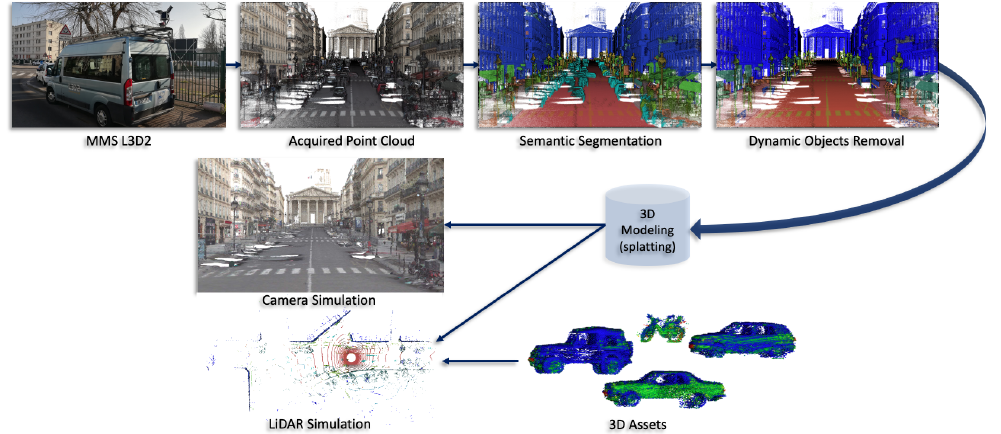
Figure 1. Starting with a point cloud acquired using a mobile mapping system (MMS), we obtain point-wise semantic labels by performing semantic segmentation. Using the semantic labels, we remove dynamic objects in the scene and perform our splats generation method. The splatted scene can then be used to simulate the different sensors. Dynamic objects can be added to the splatted scene either in the form of splatted point clouds or using a bank of CAD meshed